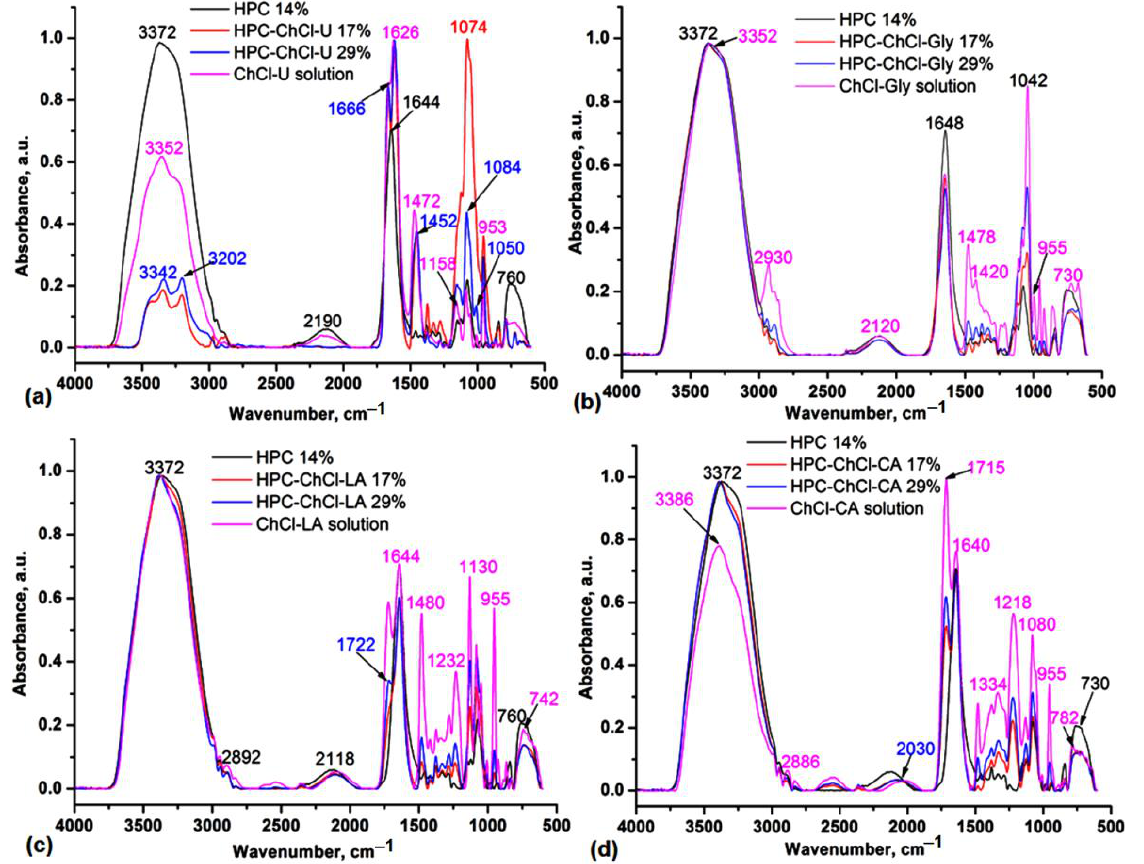
Figure 1. Comparative IR spectra in ATR (Attenuated Total Reflectance) mode of the HPC-ChCl-U ( a ), HPC-ChCl-Gly ( b ), HPC-ChCl-LA ( c ) and HPC-ChCl-CA ( d ) at 17% and 29% NADES concen- trations compared with the starting components HPC solution 14% and original NADES in solu- tion.